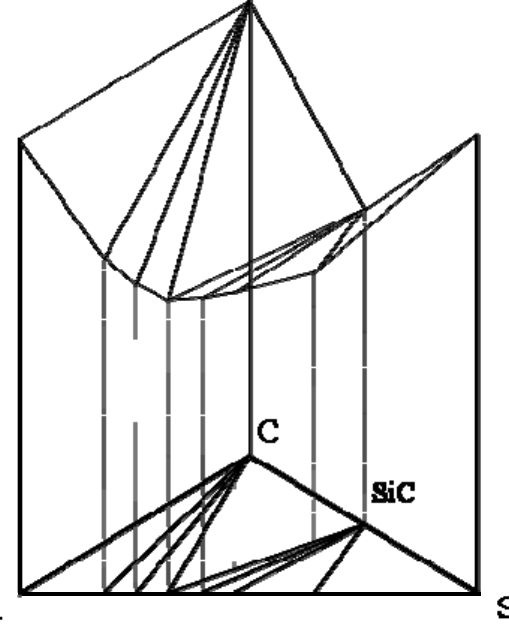
Figure 6. Schematic 3-dimensinal chemical potential diagram of the Si-Ni-C ternary system at 900 ° C